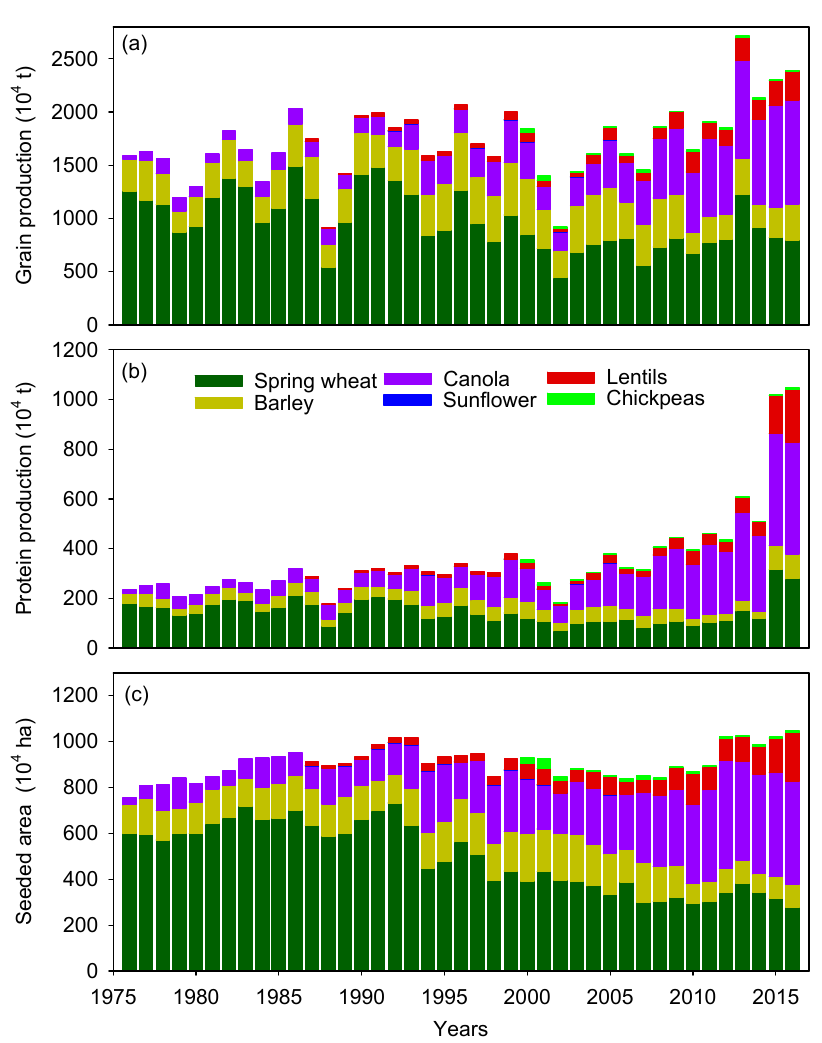
Figure 3. Inter-annual variability of total grain production, protein production, and seeded area of different crops in Saskatchewan from 1976 to 2016. ( a ) crop grain production; ( b ) crop protein production; ( c ) crop seeded areas.